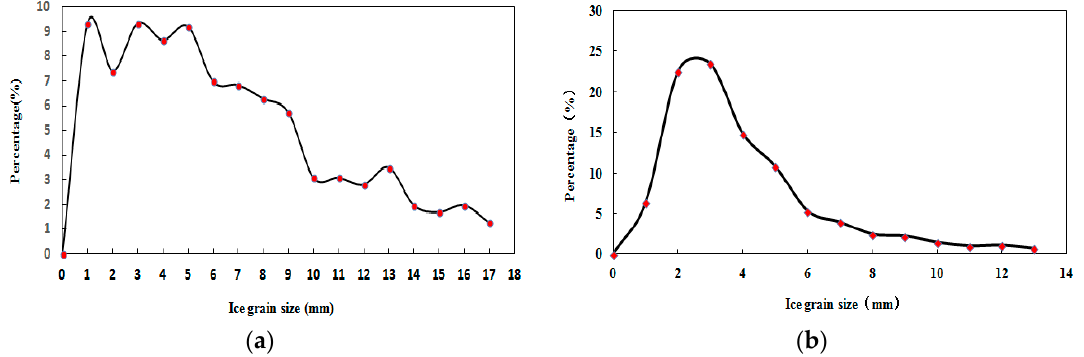
Figure 5. The grain size distribution of ice crystals: ( a ) Point A; ( b ) Point B.